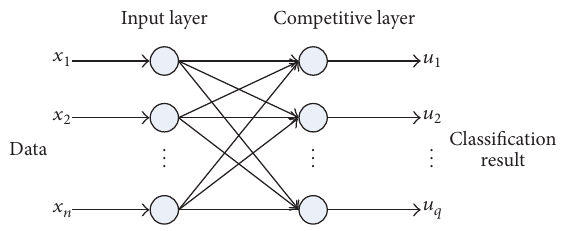
Figure 1: General structure of self-organizing, competitive neural